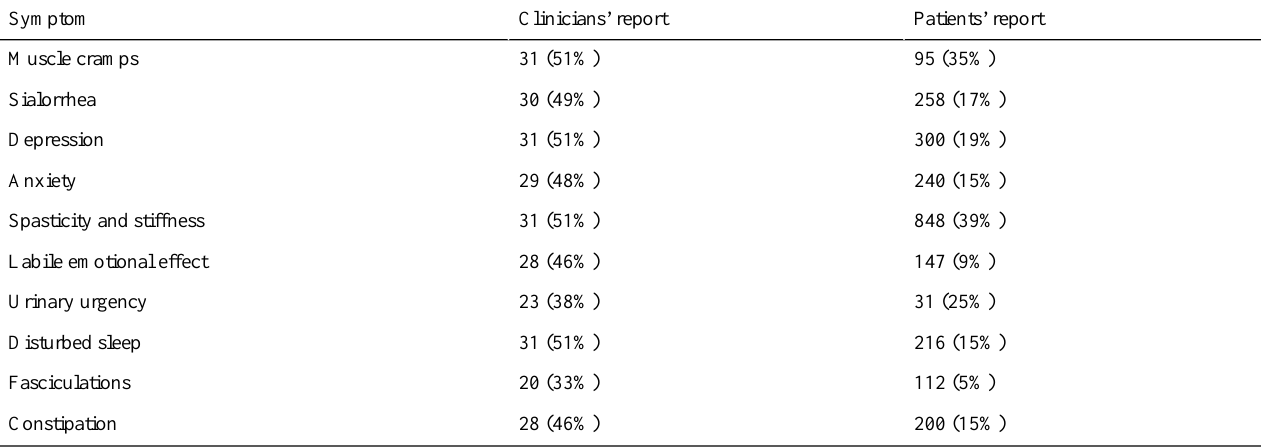
Table 1. Number of clinicians and patients who responded to the question regarding treatments prescribed or received for specific symptoms.